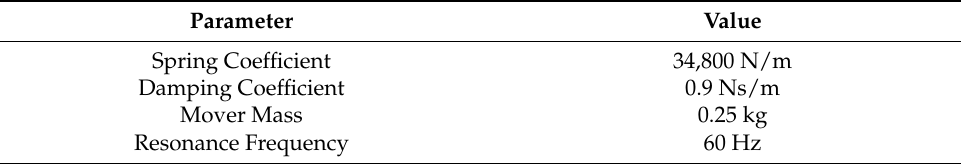
Table 3. LOM parameters.